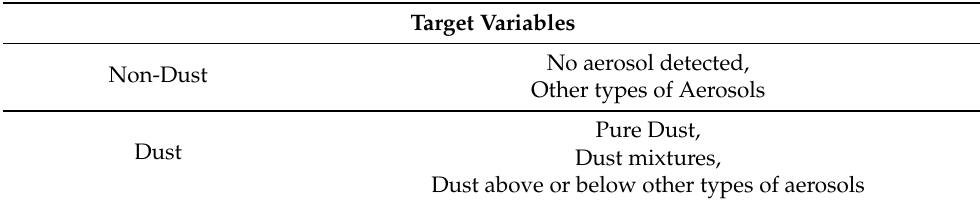
Table 1. Target variables used in the study based on CALIOP algorithm. Note that all cloudy-pixels are excluded from the